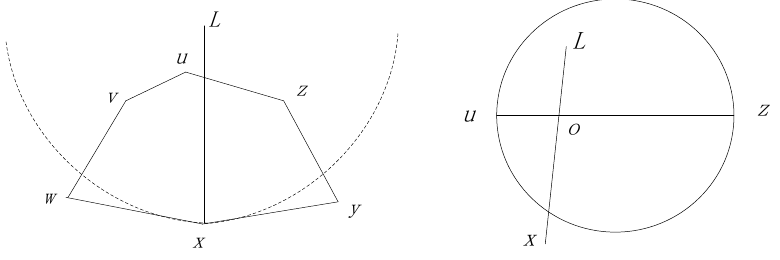
Figure 6. The destination locates out of the polygon and its simplified form.